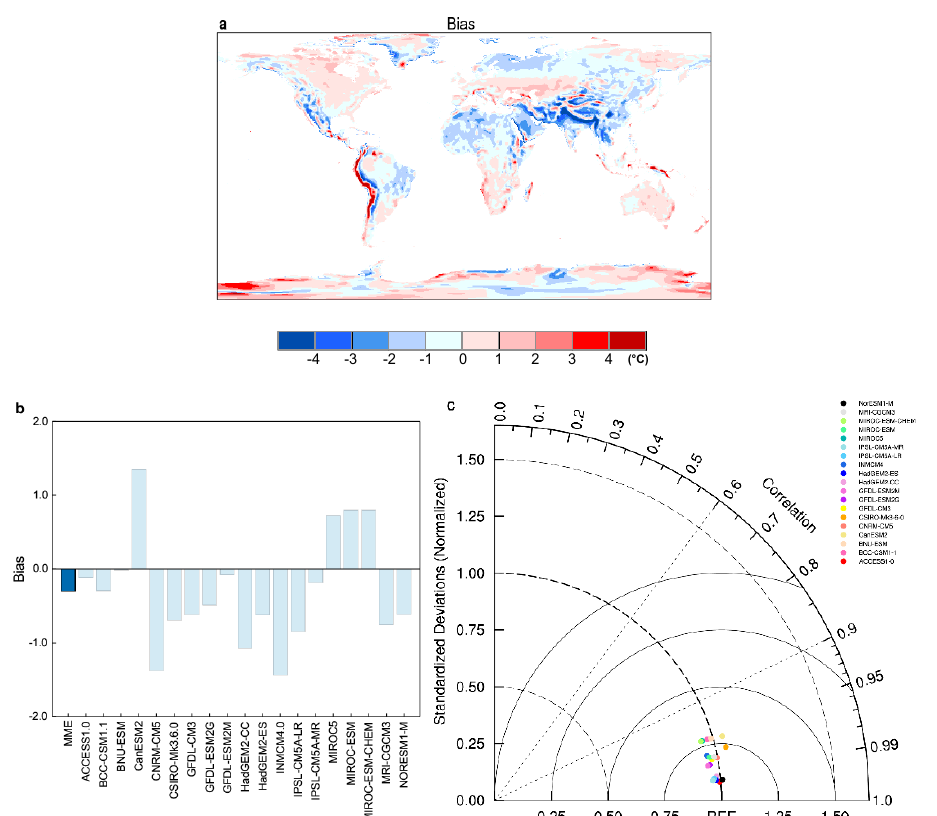
Figure 1. Spatial distribution of climatology of annual mean WBGT during the reference period (1986–2005) from ( a ) CMIP5 MME bias. ( b ) Area mean bias and ( c ) Taylor diagram for WBGT for CMIP5 individual models in comparison with ERA-Interim reanalysis.